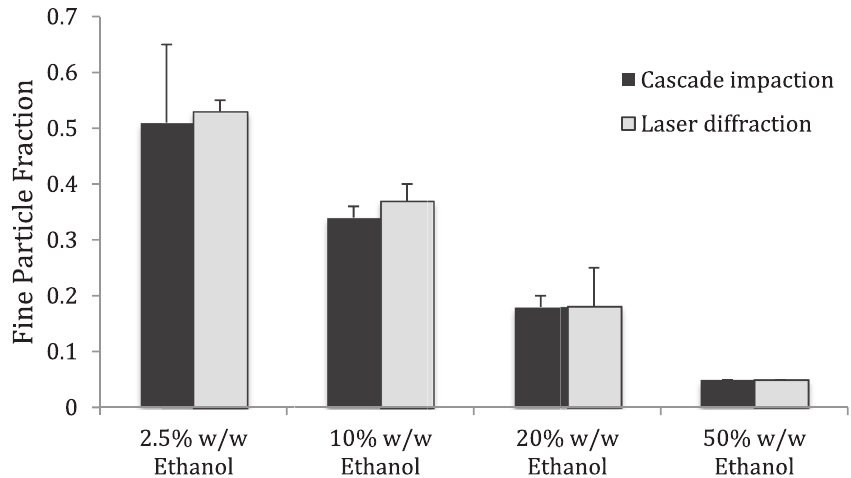
Fig. 3 Effect of ethanol concentration on the fine particle fraction (fraction of particles less than 5 microns) in HFA 134a metered dose inhaler